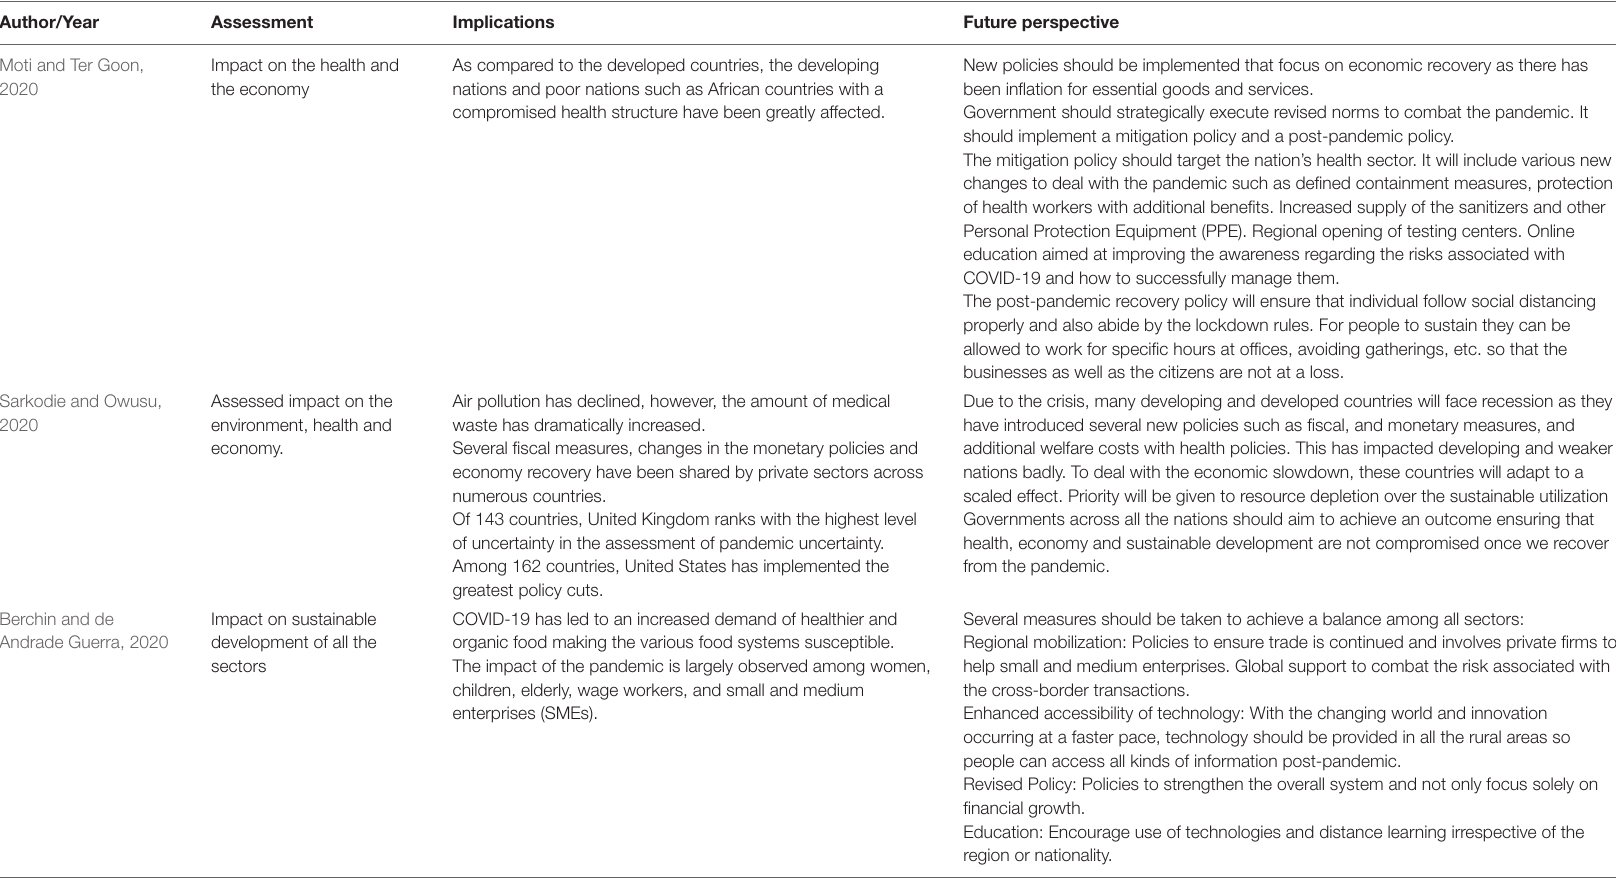
TABLE 1 | Impact of COVID-19 and future perspective to improve health, economy, sustainability, and quality of